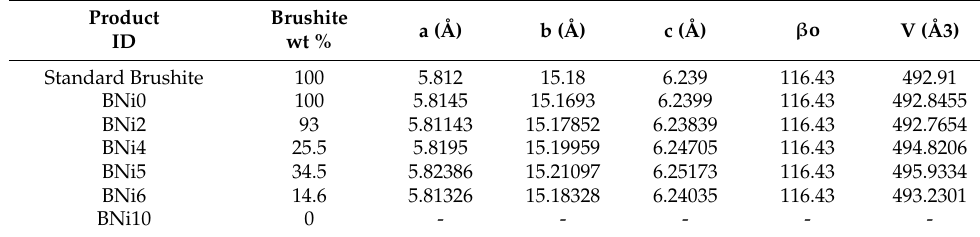
Table 2. The unit cell parameters for brushite are derived from the XRD scans (Rietveld refinement).